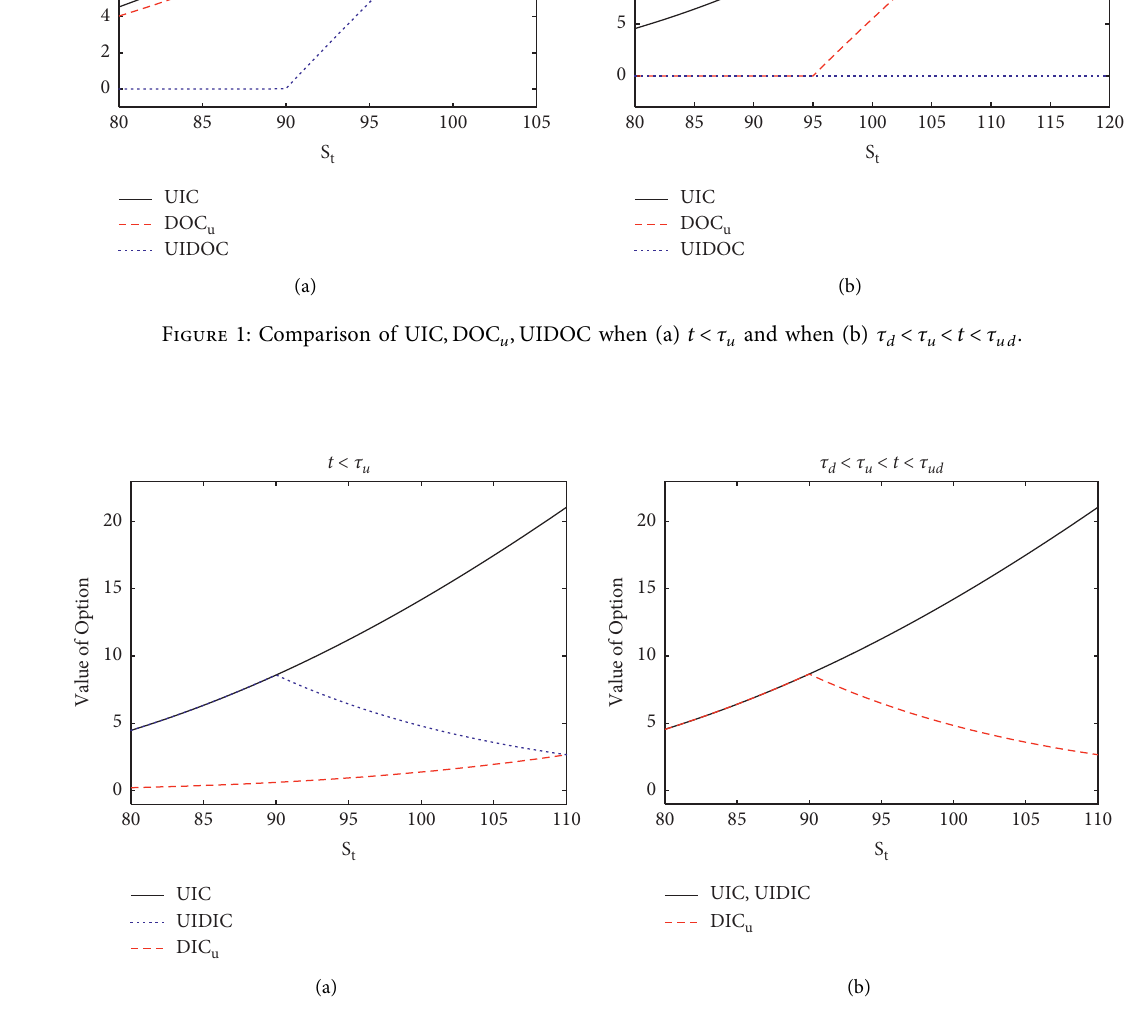
t < τ u when (a) u and (b) τ d < τ u <